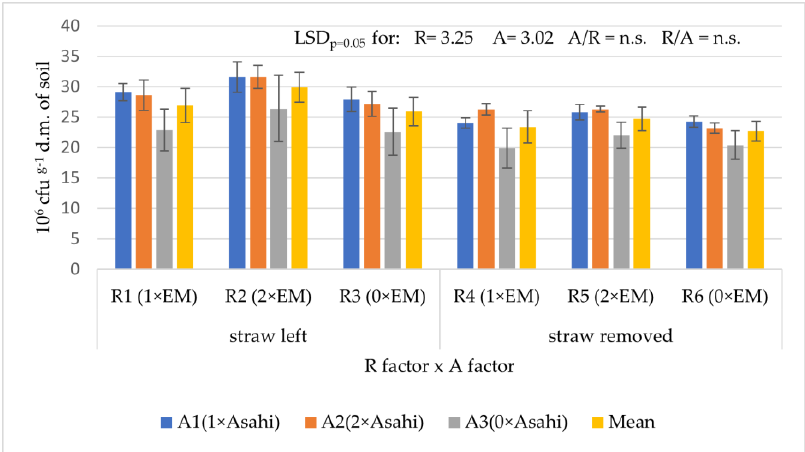
Figure 4. Total number of microorganisms in the soil depending on the management of plant residues with the addition of the biopreparation EM (R factor) and the application of the biostimulant Asahi (A factor) in spring barley cultivation. Error bars represent standard deviation (abbreviations: see Table 1).